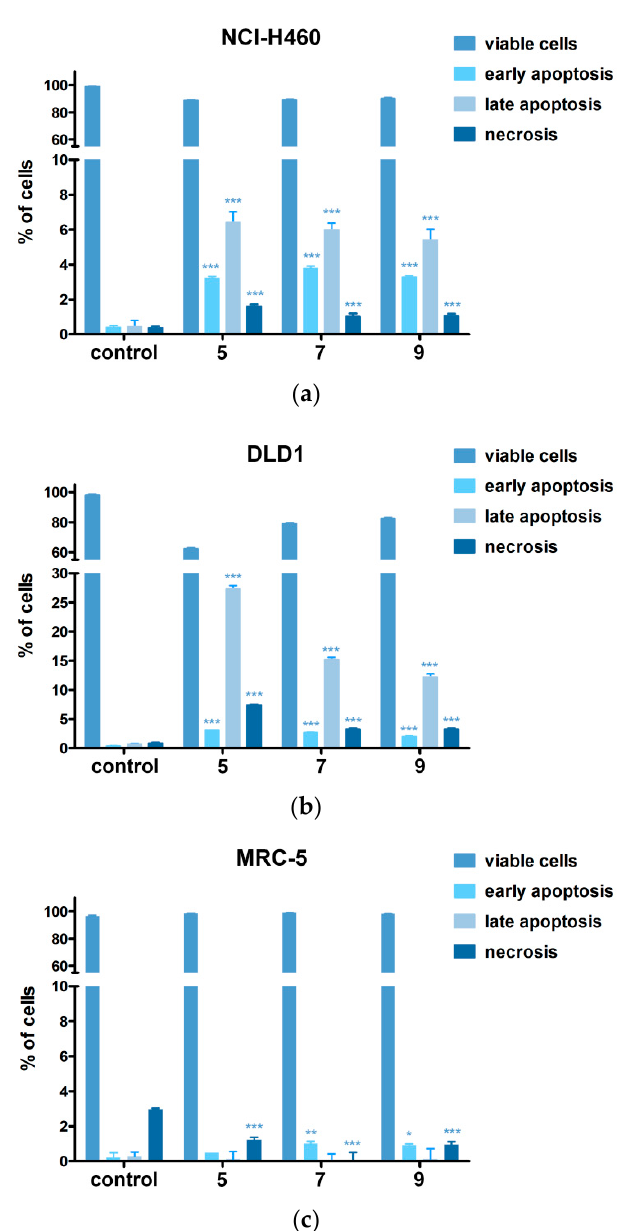
Figure 6. Cell death analysis confirmed good selectivity profile of Hsp90 inhibitors. Cell death